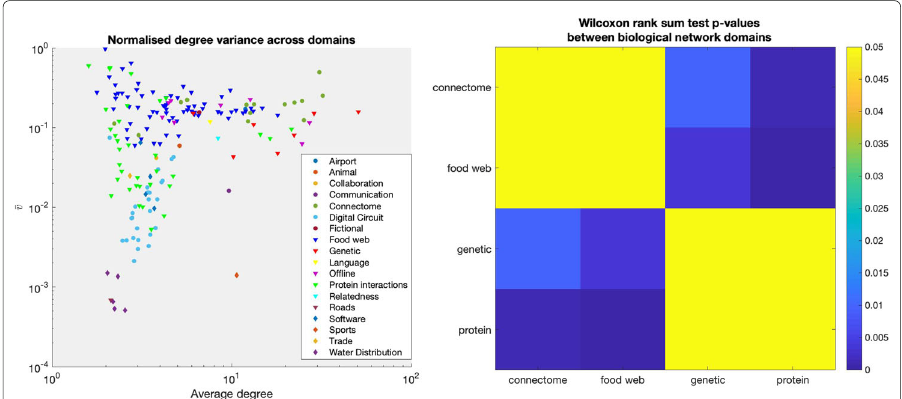
Fig. 5 Normalised degree variance of 184 real-world networks plotted against their average degrees and marked by sub domain, left, and Wilcoxon rank sum tests of normalised degree variance within biological network domains,